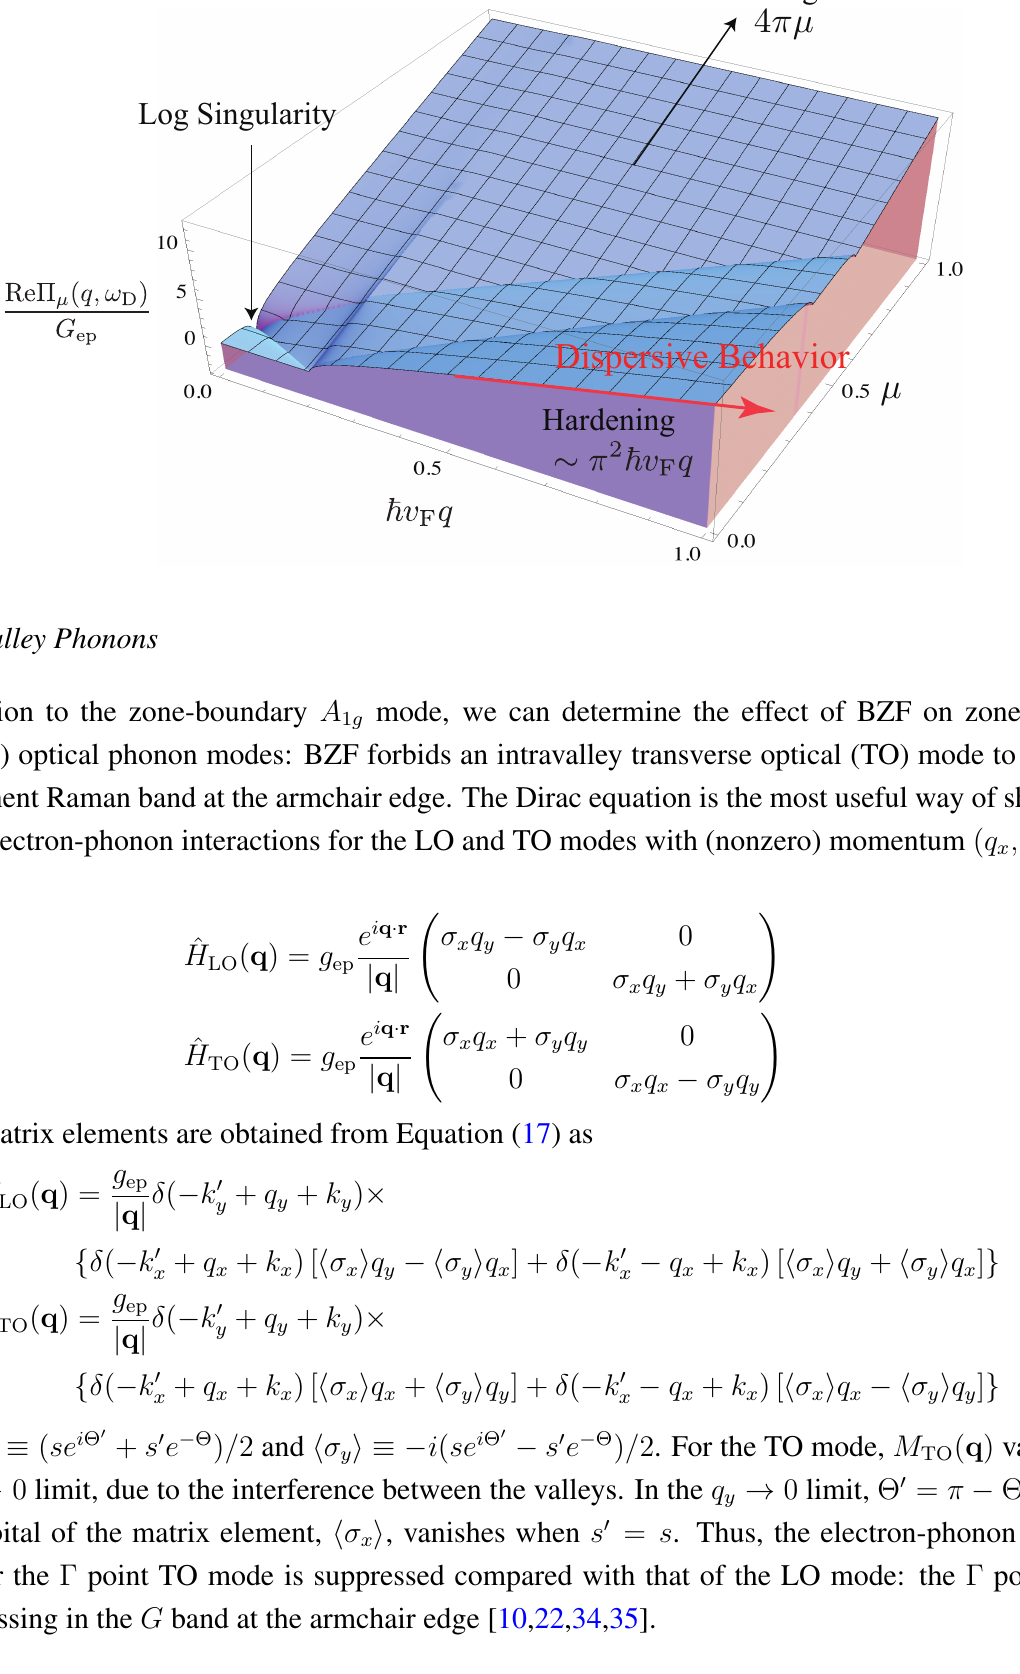
q and µ are given in eV. Note that F